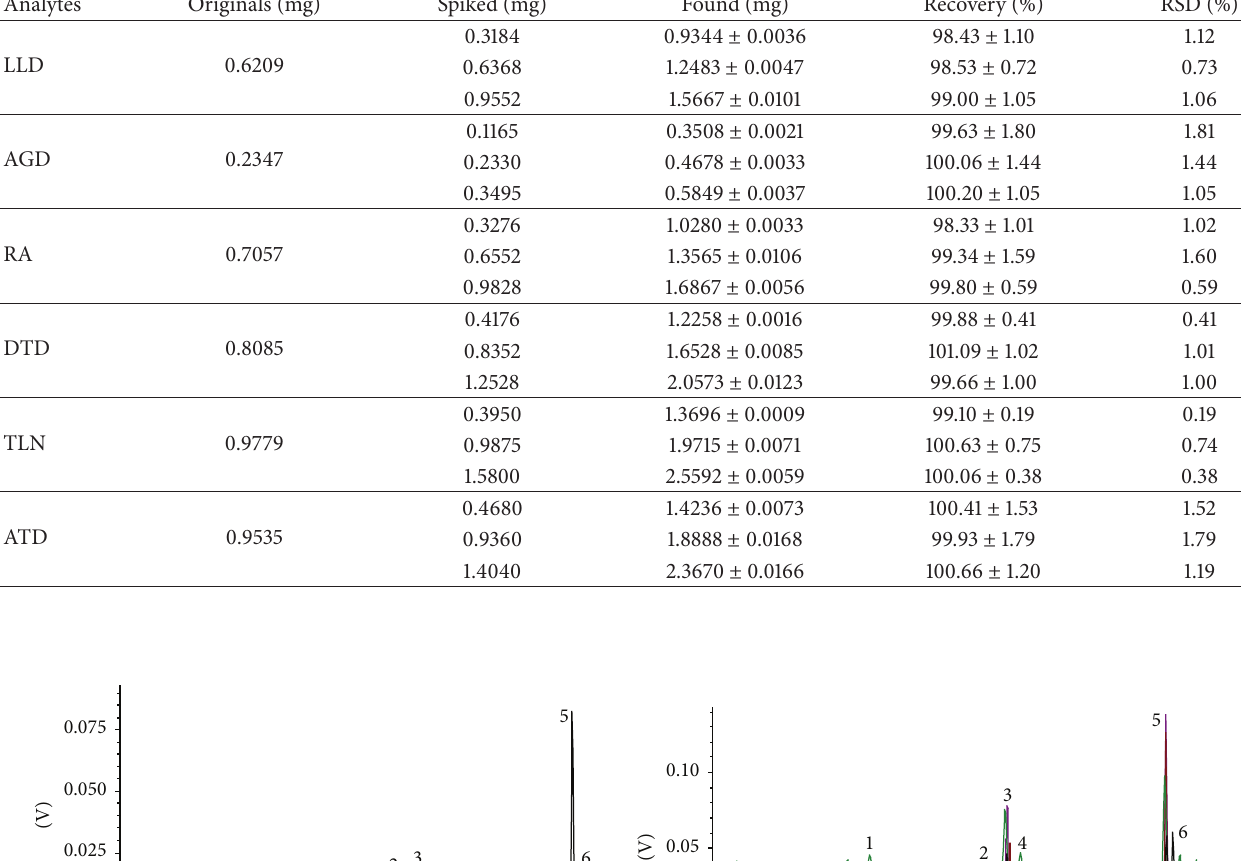
Table 6: Recovery test for the determination of the investigated analytes (mean ± SD, 𝑛 = 3 ).